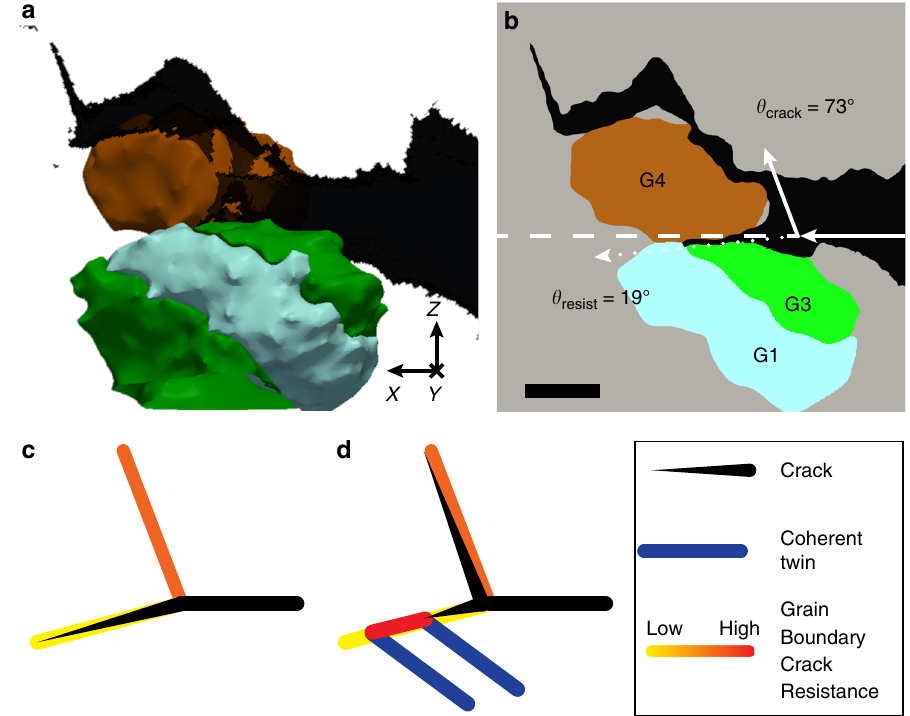
Fig. 4 Twin intersection toughening. a Crack de fl ection event (CDE) #6 taking place at a boundary with low-index plane (BLIP) created by the impingement of a twin lamella on a grain boundary (GB). b A 2D section through the 3D reconstruction in a showing traces of the incoming, de fl ected, and grain boundary planes (see schematic Fig. 2b) as well as values of the dihedral angles, θ crack and θ resist , used to identify the CDE. Solid arrows indicate the path of the crack, the dashed line indicates the nominal crack direction, and the dotted arrow indicates the path along the crack-resistant boundary that de fl ected the crack. The angles indicated are the dihedral angles de fi ned in Fig. 2b. Scale bar: 50 μ m. c, d Schematic showing the role of twin lamellae in altering the crack-propagation resistance of GBs. c A crack reaching a triple junction propagates along a low-toughness GB that is aligned well with the crack plane. d A twin lamella intersecting the GB locally alters the GB character, creating a BLIP that arrests the propagating crack and de fl ects it onto a different, more tortuous